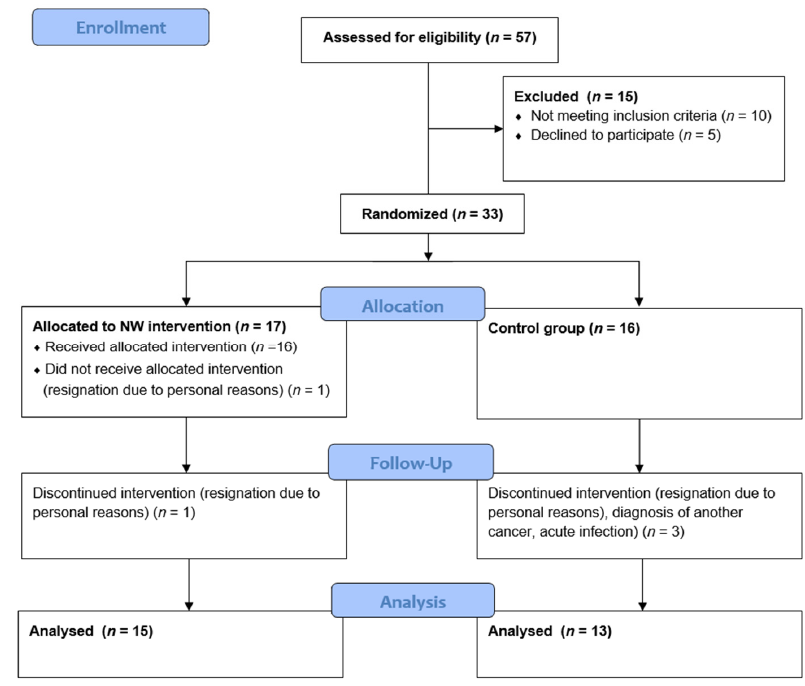
Figure 1. CONSORT 2010 patient flow diagram.